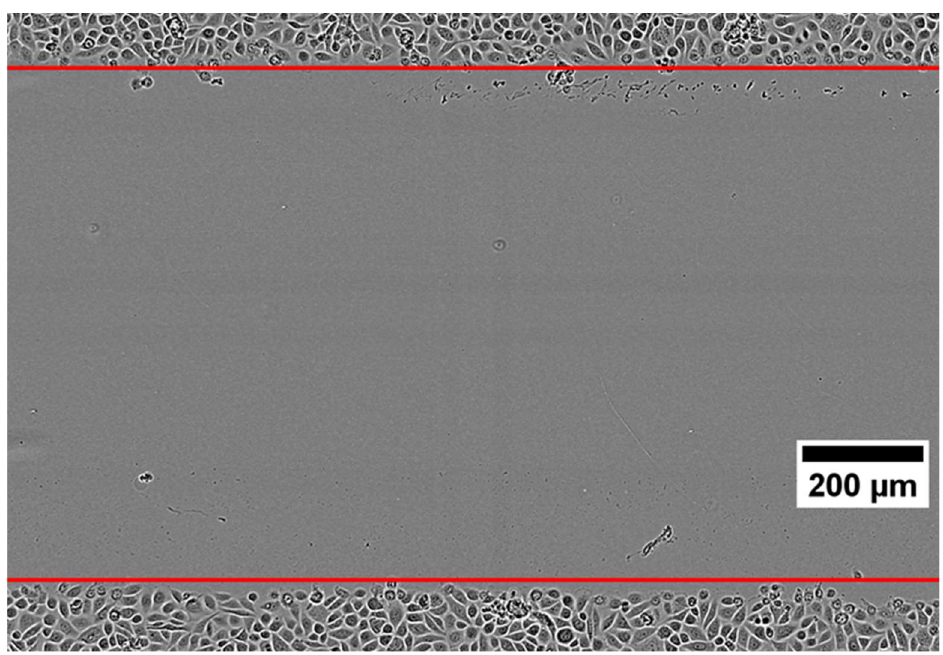
Figure 6. Automatically identified leading edges visualized as two horizontal red lines in the first frame of a control experiment.